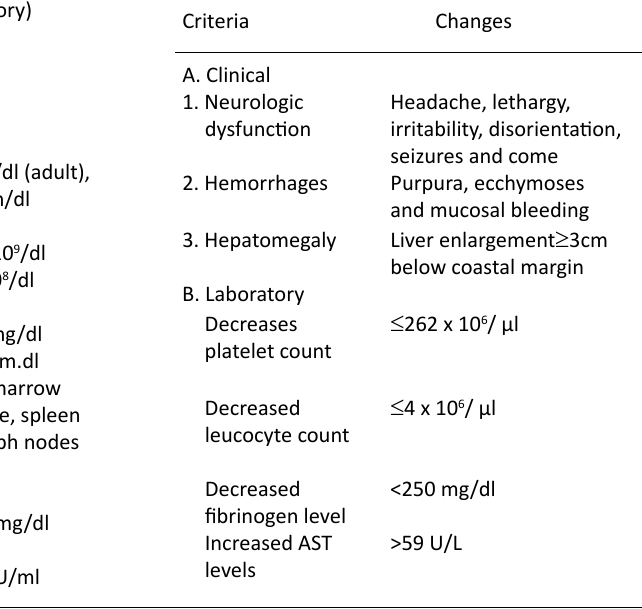
Table 4. Diagnostic criteria for MAS complicating sJIA